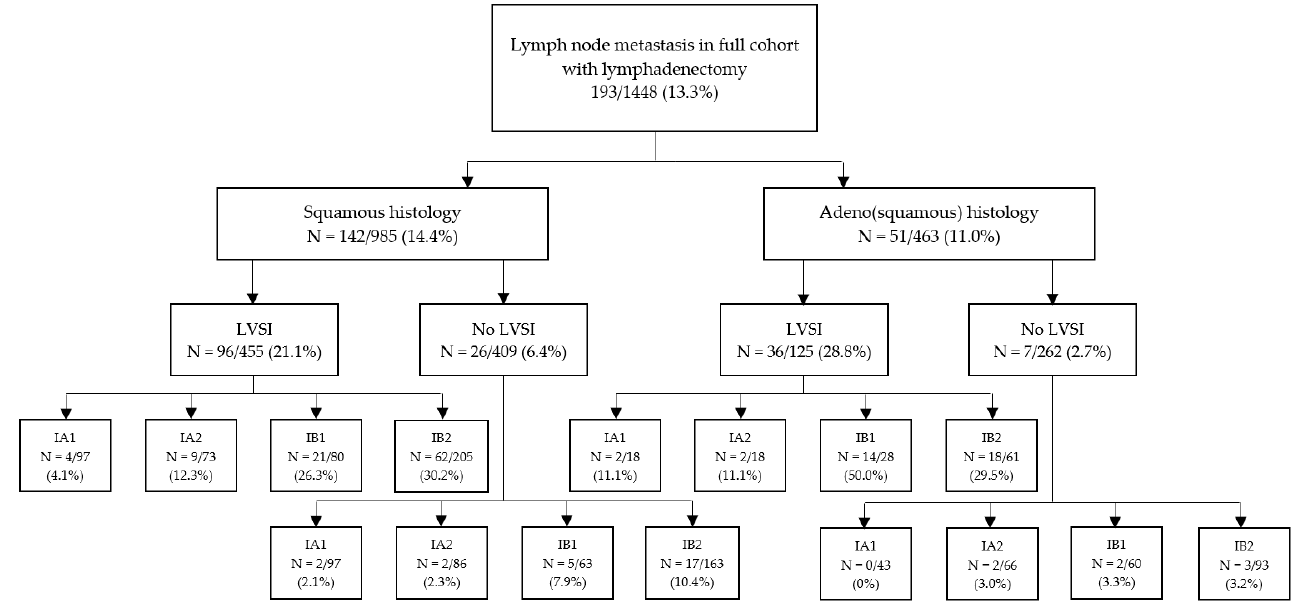
Figure 4. Percentage of patients with lymph node metastasis according to histological characteristics and FIGO stage.